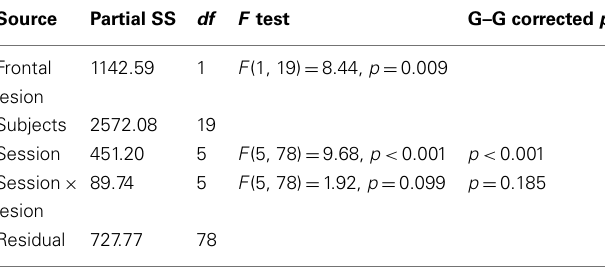
Table 3 | Results of repeated measuresANOVA of Chen et al. (2012)